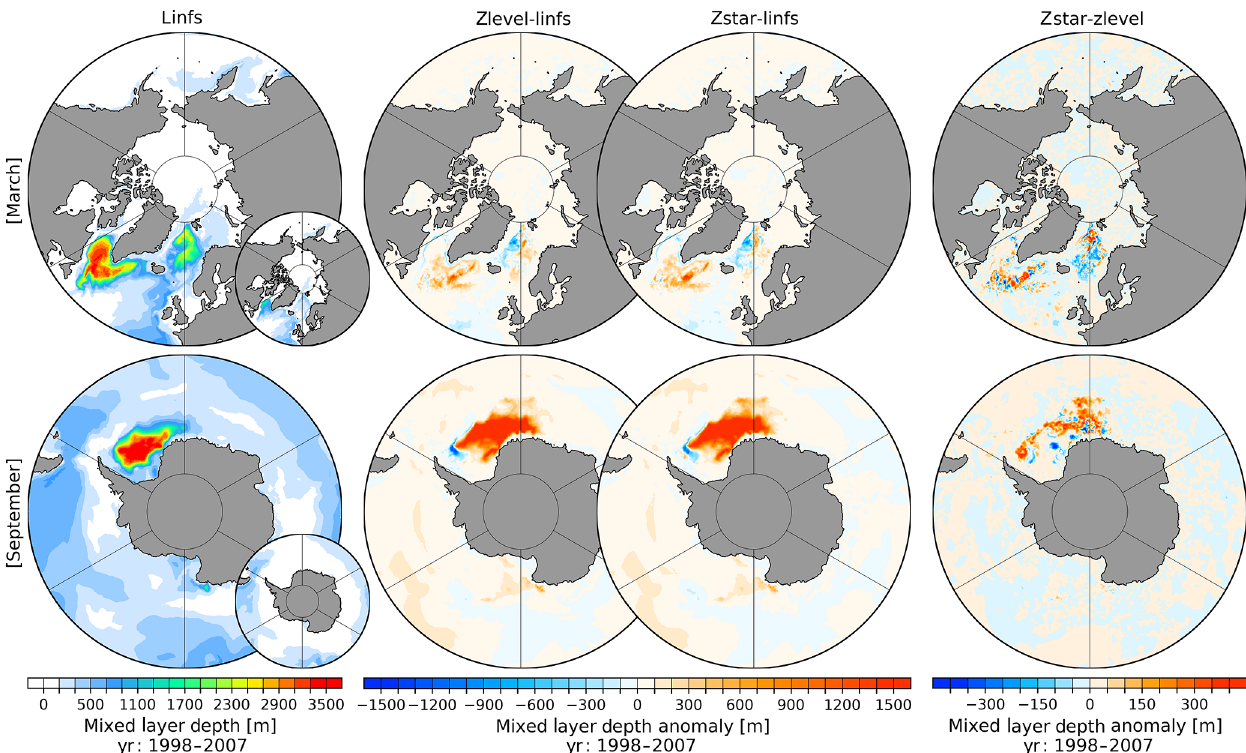
Figure 4. March (upper row) and September (lower row) mixed layer depth after the definition of Monterey and Levitus (1997, MLD1) for the linear free-surface case (linfs, first column) averaged for the time interval of 1998–2007. The second and third columns show the anomalous MLD1 for the full free-surface modes zlevel (second column) and zstar (third column) with respect to the linfs mode. The fourth column presents the anomalous MLD1 between the two full free-surface modes (zstar minus zlevel). The small inset plot shows the mixed layer depth after the definition of Large et al. (1997,